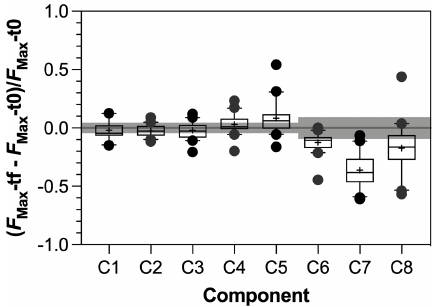
Figure 7. Response ratio of PARAFAC components during incu- bation experiments with tf = day 28 and t0 = day 0. Grey bars rep- resent threshold of significance above or below which significant production or consumption of component was identified. See text for